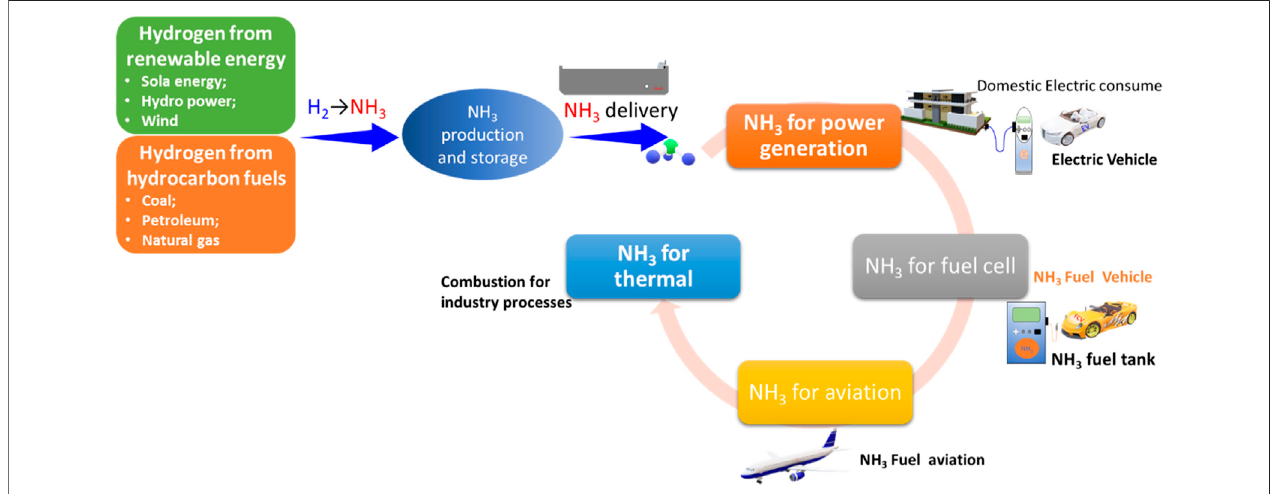
FIGURE 1 | Application of NH 3 as a near zero emission fuel system.